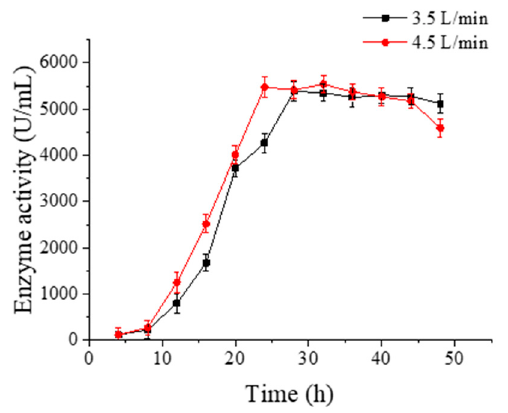
Figure 7. Effects of ventilation on enzyme activity during cultivation of palm curtain immobilized Bacillus circulans ATCC 21783 in a 5 L tank.